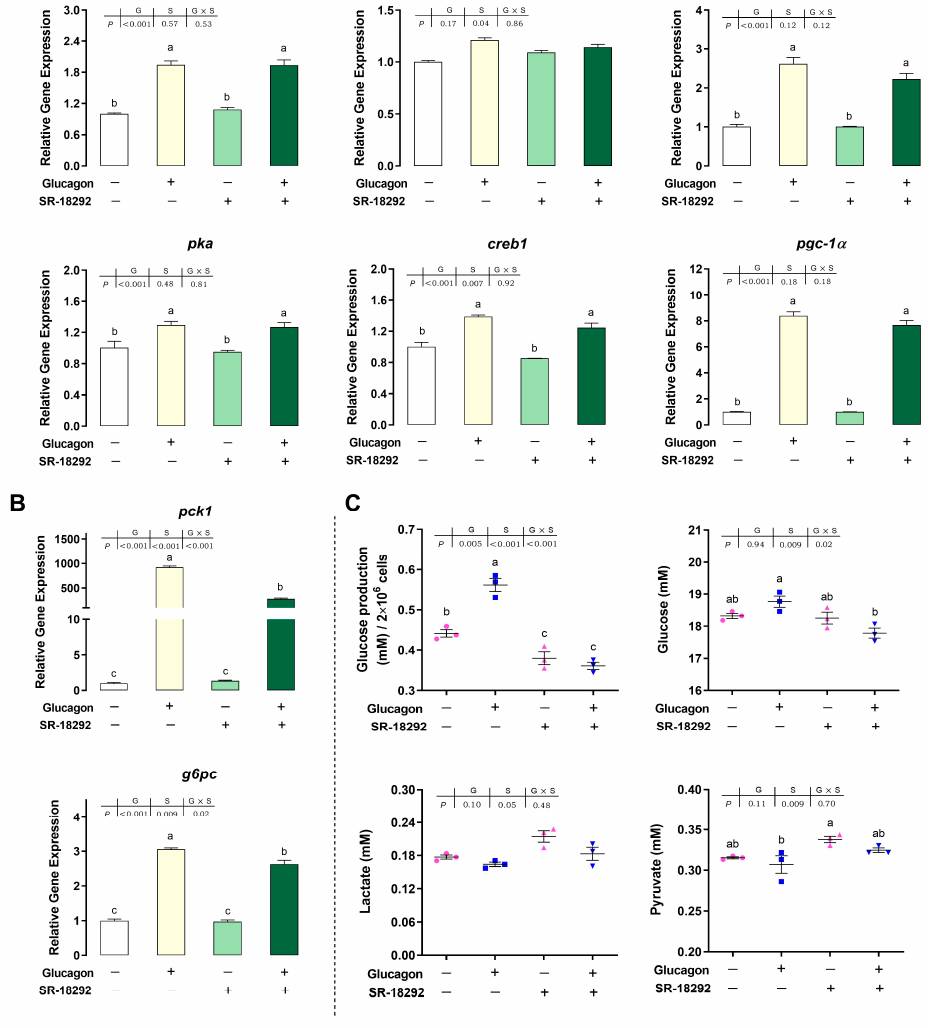
Figure 8. SR-18292 inhibits the glucagon pathway in hepatocytes by targeting PGC-1 α . ( A ), qPCR analysis of the mRNA levels of glucagon pathway-related genes ( gcgr ; gnas ; adcy2 ; pka ; creb1 ; pgc-1 α ) following glucagon stimulation and treatment with SR-18292 (20 µM) in hepatocytes. ( B ), qPCR analysis of the mRNA levels of gluconeogenic genes ( pck1 and g6pc ) following glucagon stimulation and treatment with SR-18292 (20 µM) in hepatocytes. ( C ), Glucose production in hepatocytes and glucose, lactate, and pyruvate concentrations in the medium following glucagon stimulation and treatment with SR-18292 (20 µM). All data are expressed as mean ± SE, n = 3, two-way ANOVA with Tukey post-hoc test. Values with different letters mean statistical differences ( p < 0.05). G: glucagon treatments; S: SR-18292 treatments; G × S: interaction between glucagon and SR-18292